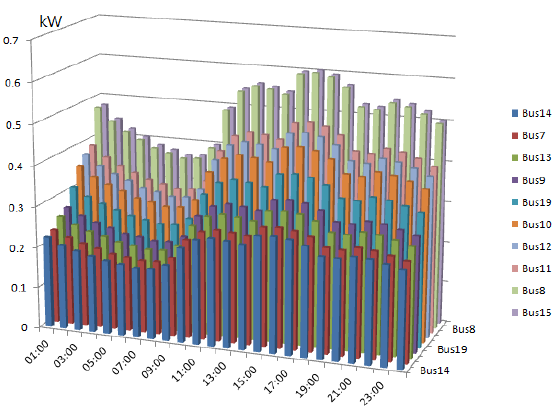
Figure A1. Inelastic loads (MW) in factory power system.